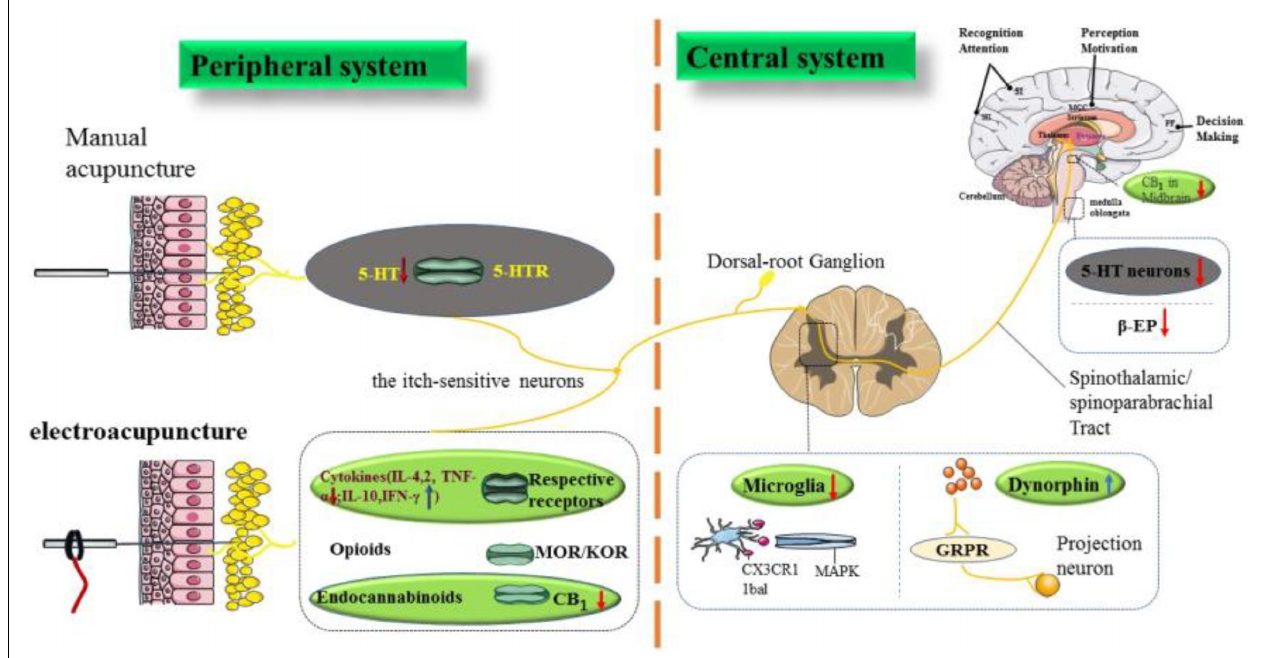
FIGURE 1 | The neurobiological mechanism of acupuncture to relieve itching. The biomechanical stimulation signal of acupuncture can inhibit pruritus via acting on different levels of targets. In the periphery, manual acupuncture downregulates 5-HT (acute pruritus) and blocks its receptor expression. Electroacupuncture regulates cytokines and endocannabinoid receptor CB1 (chronic itch), and opioid peptide receptor is also one of the targets involved in acupuncture to relieve itching. In the center, acupuncture can regulate microglia and DNY in the spinal cord to treat chronic pruritus in animals. 5-HT neurons and β -EP in the medulla oblongata, and CB 1 in the midbrain are also its targets. Putamen is a common target of acupuncture treatment for acute and chronic pruritus in humans. As shown in the figure, the red arrow represents the downregulation effect of acupuncture, while the blue arrow represents the upregulation effect of acupuncture. Among them, the purple font represents targets in humans, the yellow font represents both targets in humans and animals, and the rest represent animal research. The gray ellipses represent targets related to acute itch, the green ellipses represent targets related to chronic itch, and the others are both. SII, secondary somatosensory cortex; SI, primary somatosensory cortex; PF, prefrontal